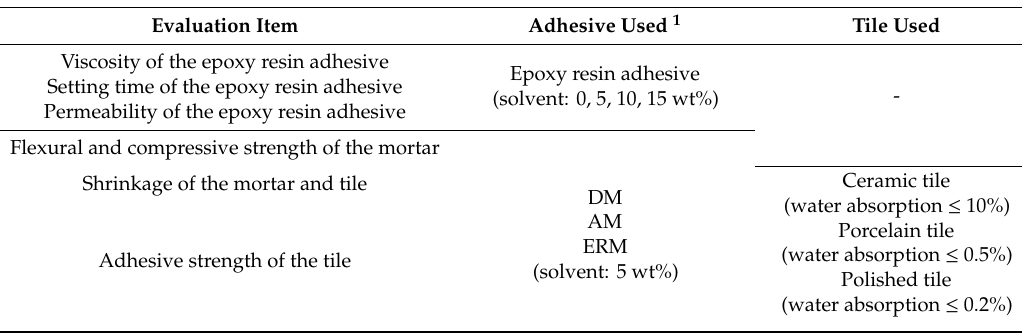
Table 2. Experimental